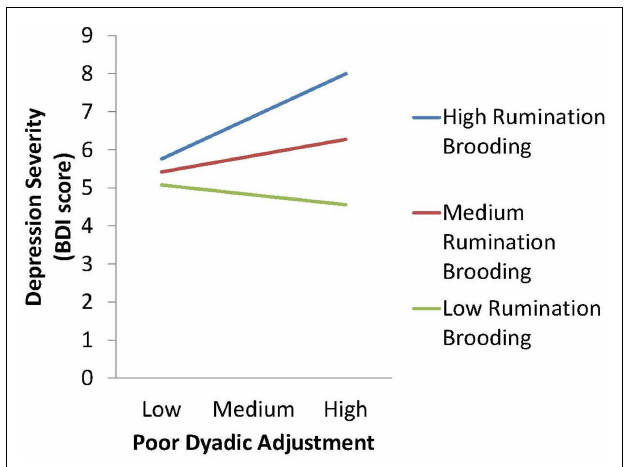
FIGURE 2 | Interaction effect of baseline poor dyadic adjustment and rumination brooding on 3 month depression severity,